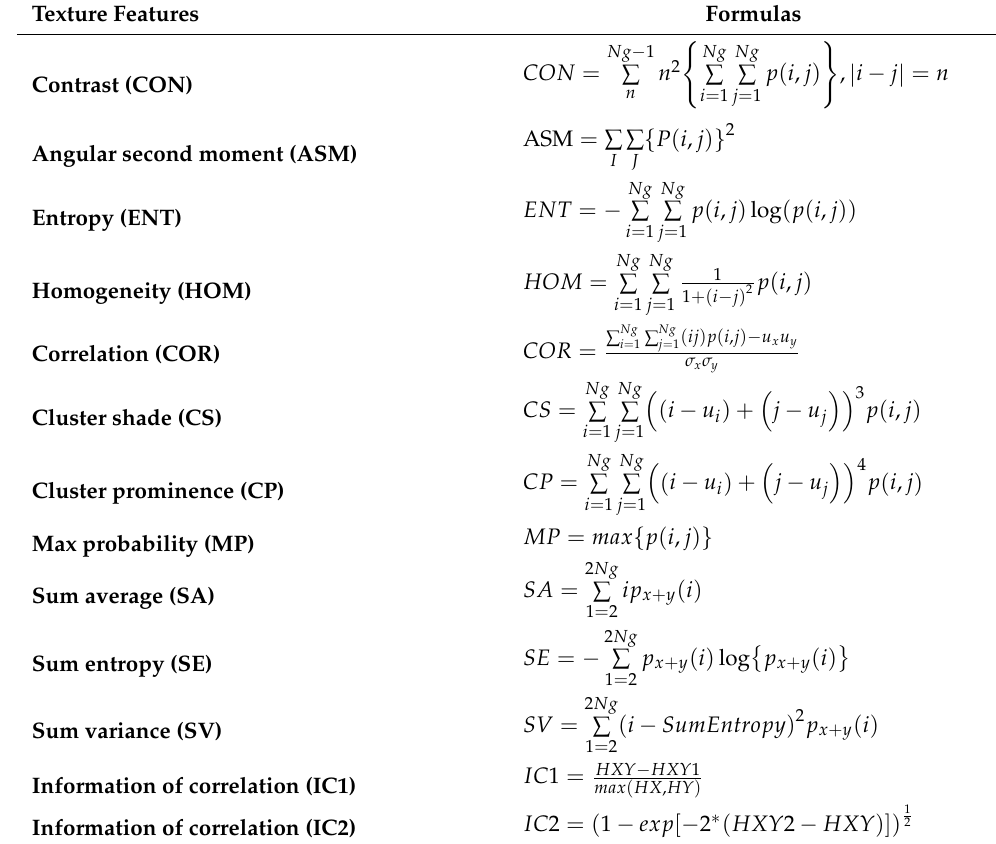
Table 1. GLCM texture feature calculation